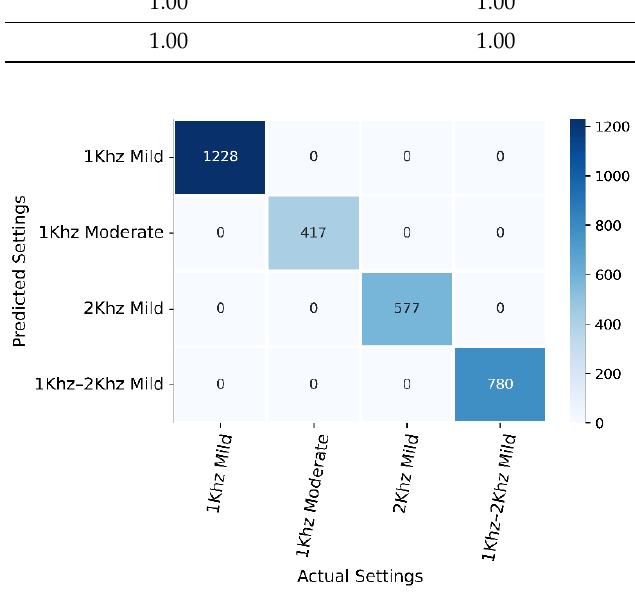
Figure 10. Confusion matrix of preset and subset selection.